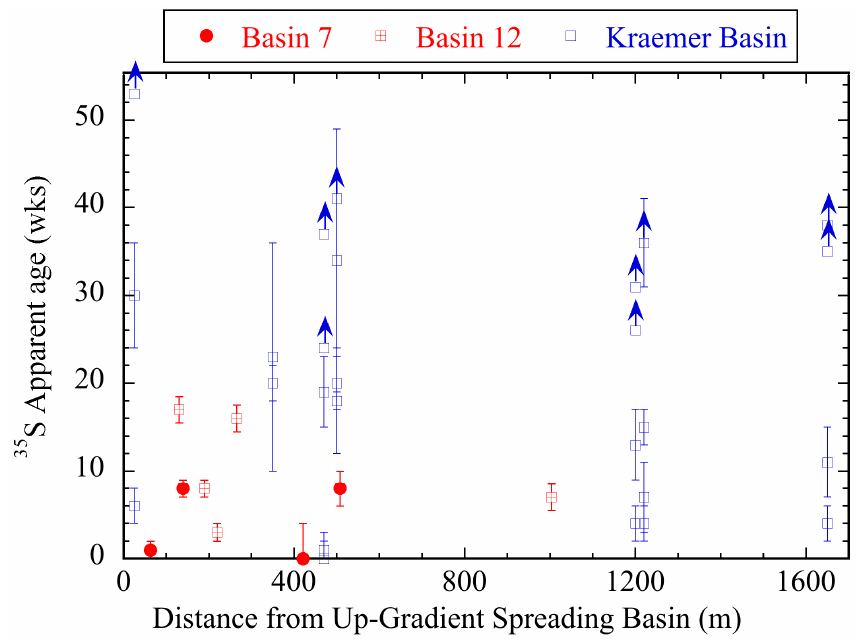
Figure 2. Apparent 35 S age plotted against distance down gradient for the nearest spreading basin. The two transects near the Atlantis MAR site are in red and the transect near the OCWD’s Kraemer Basin is in blue. Samples with no detectable 35 S are indicated with arrows rather than error bars. See Tables 2 and 3 for the data.